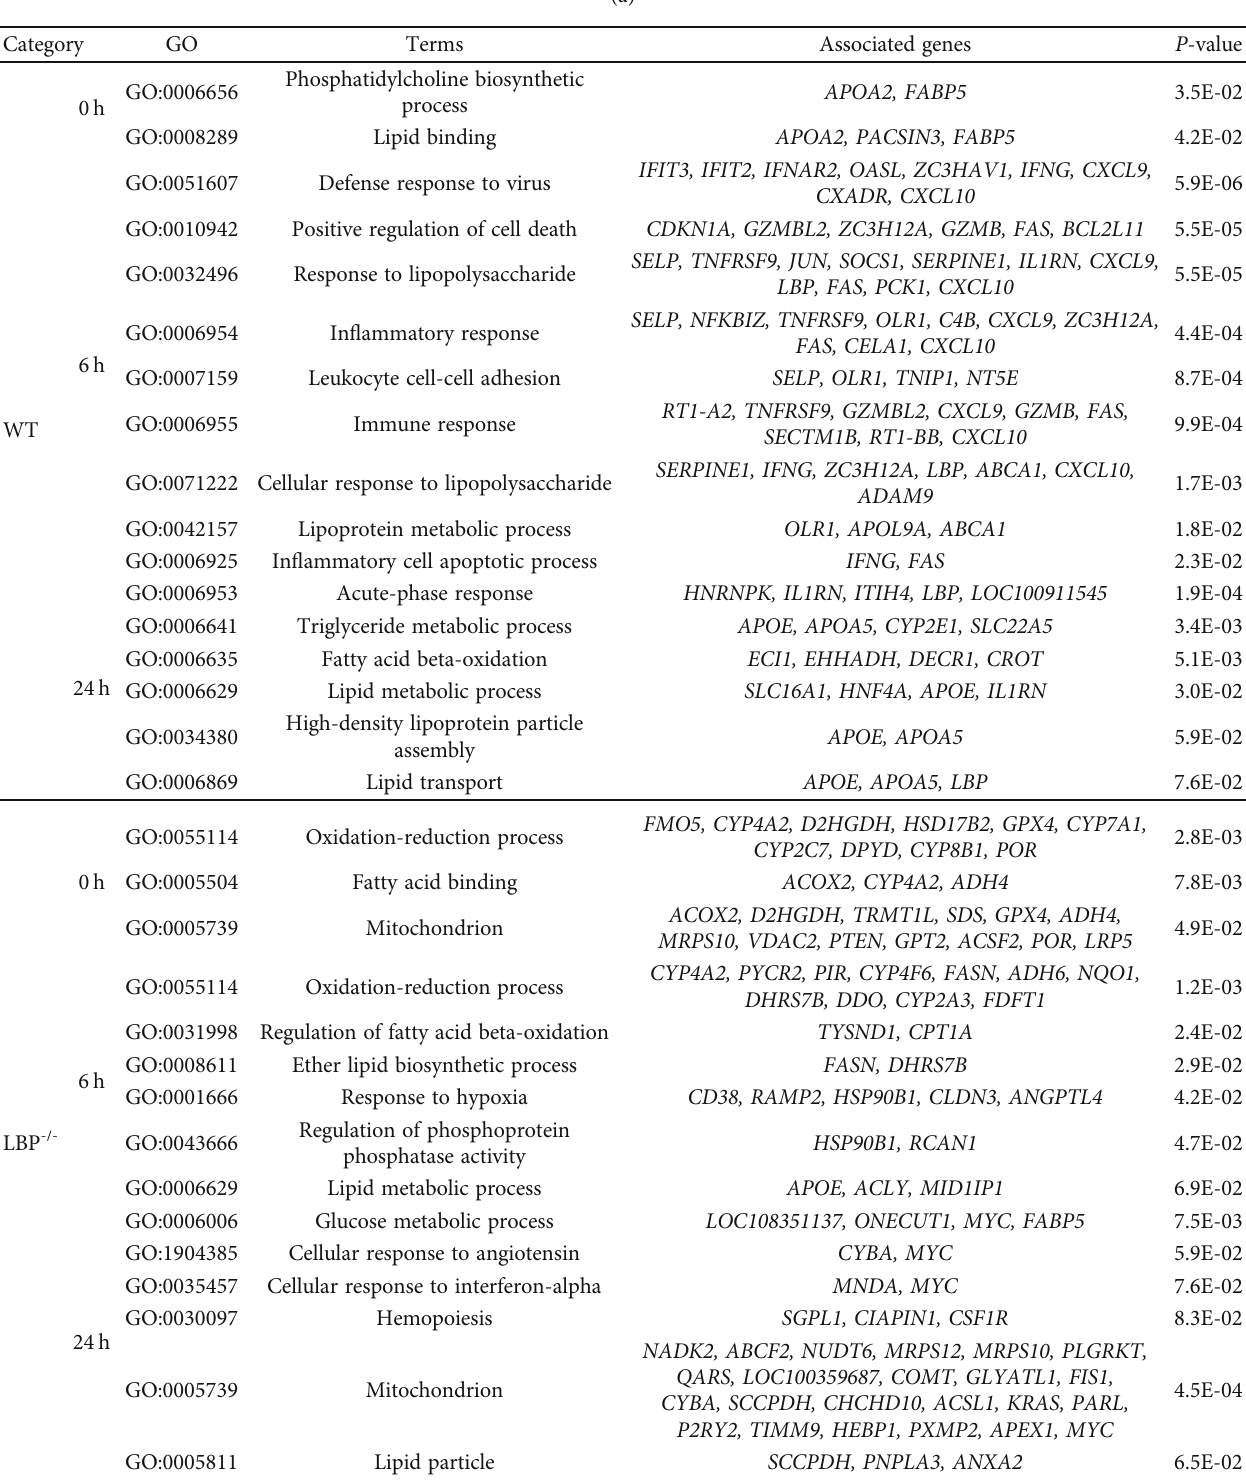
Table 1: Associated genes enriched in representative GO terms and pathways. (a) Representative GO terms and related genes involved in the WT and LBP-de fi cient groups after LPS injection. (b) Interested pathways enriched from DEGs between WT and LBP-de fi cient rats. (a) Category GO Terms Associated genes P